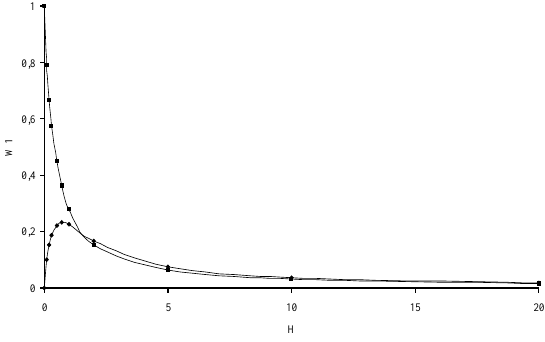
Fig. 9. The probability of atomic departures from the slit sys- tems without collisions with the walls and after a single colli- sion with the walls. ■ - W 1(0;0), ♦ - W